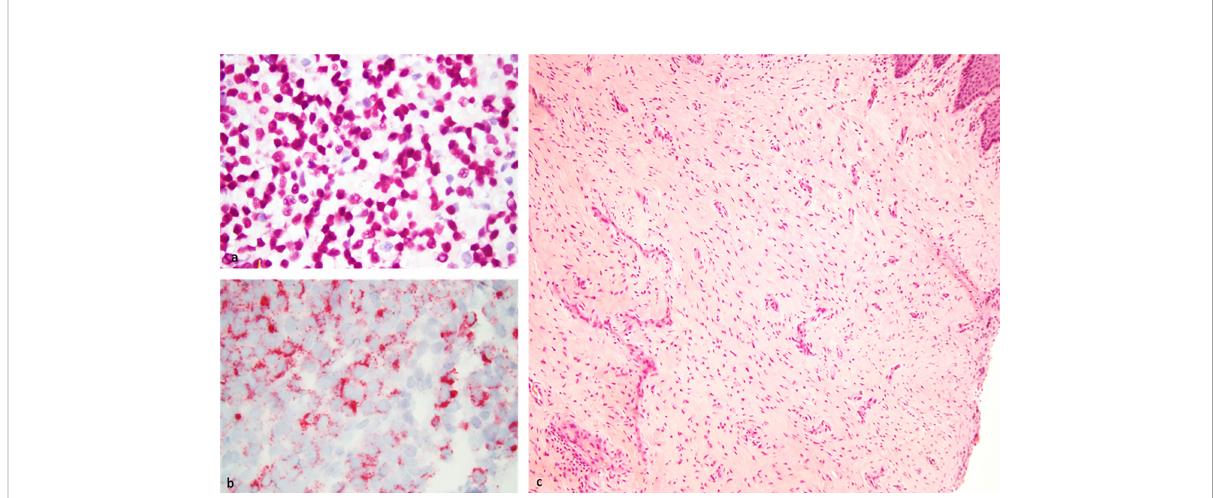
FIGURE 2 Left: Histology slides at baseline showing neoplastic cells using SOX10 (A) and HMB45 (B) immunostains at 63X magni fi cation. Right: Biopsy of tumor site displaying complete resolution of the tumor with no viable tumor cells and scar tissue formation as assessed 3 months following ipilimumab and nivolumab neoadjuvant therapy (C)